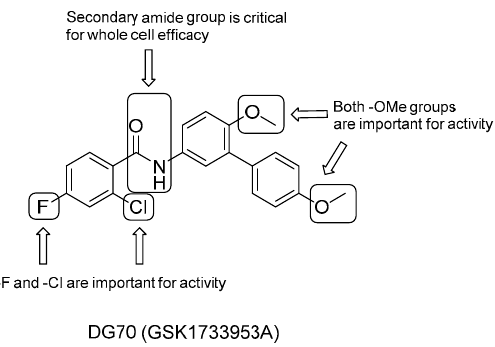
Figure 16. The chemical structure of DG70 and SARs of analogues.